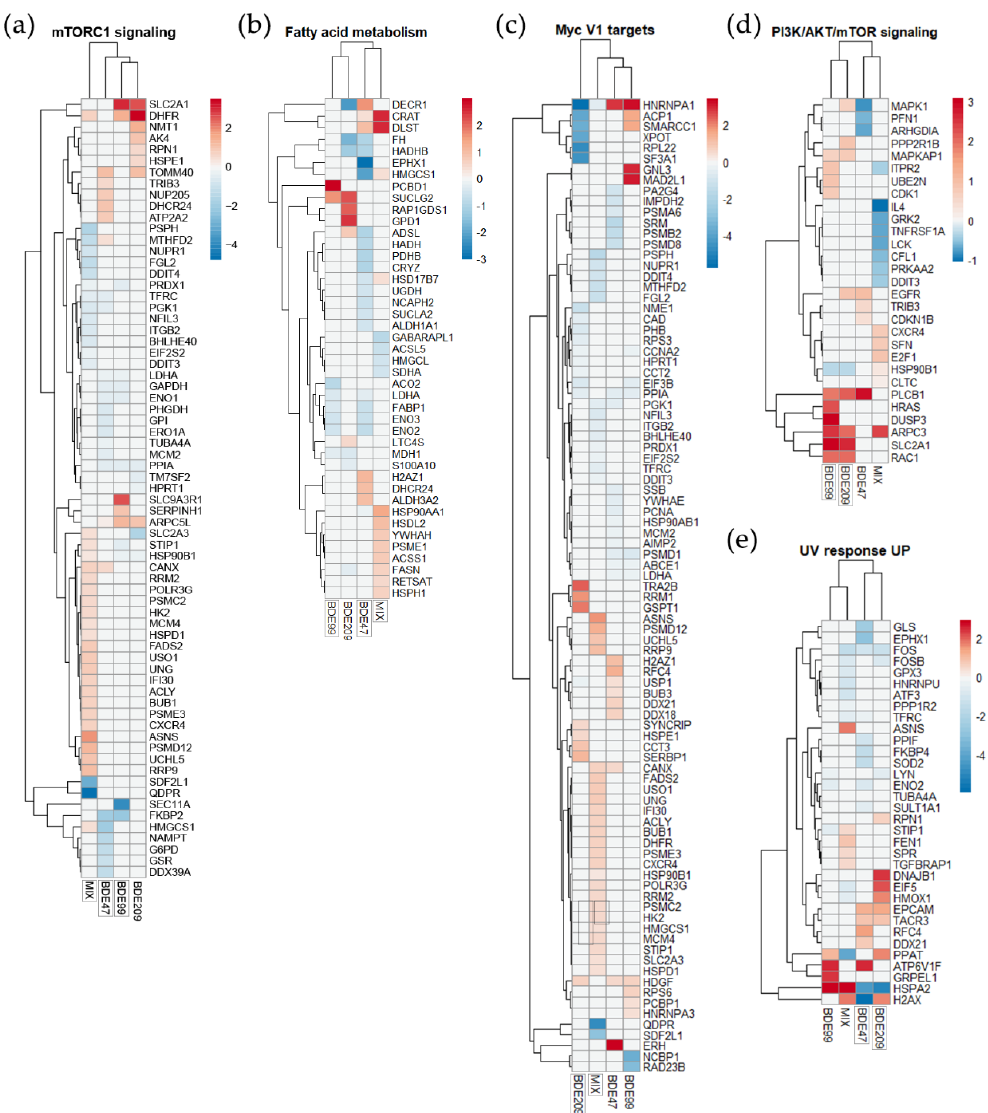
Figure 3. Heatmaps of combined DEGs and DEPs associated with the significantly enriched Hallmark gene sets ( a ) mTORC1 signaling, ( b ) fatty acid metabolism, ( c ) Myc V1 targets, ( d ) PI3K/AKT/mTOR signaling, and ( e ) UV response UP, in HepG2 treated for 72 h with BDE-47, -99, -209 and their ternary mixture (MIX) at 1 nM. Frames around names indicate which congener/MIX treatment significantly enriched the Hallmarks.